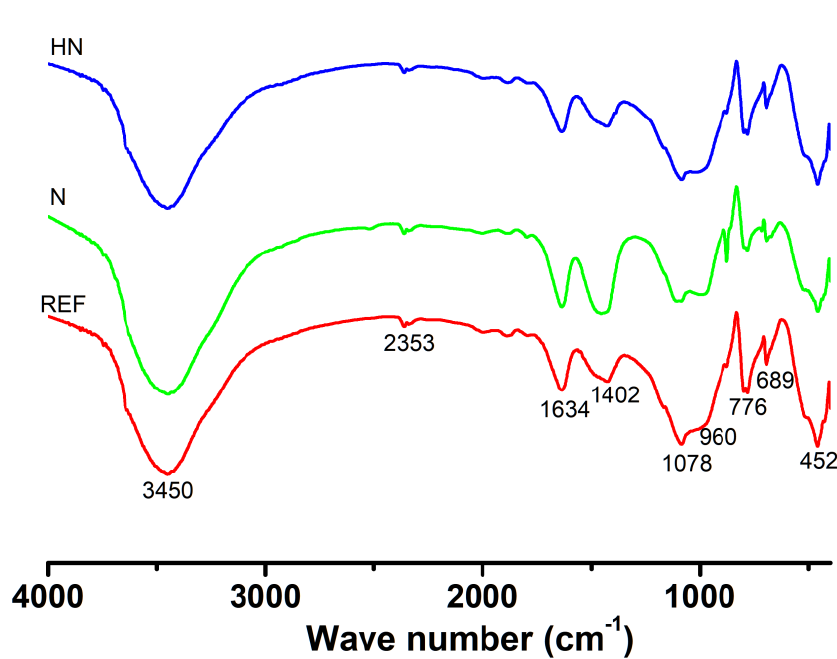
Figure 5. FTIR patterns of specimen exposed to seawater for 28 d.